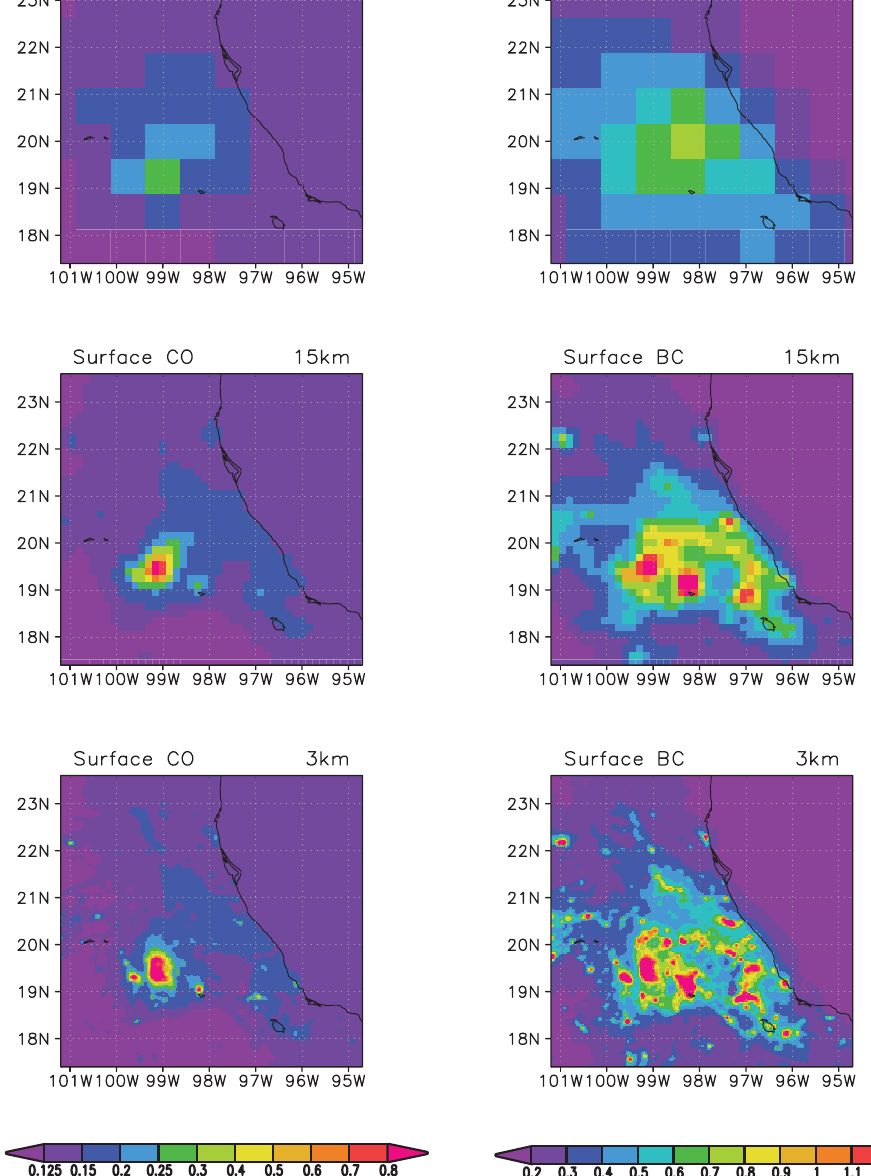
Fig. 5. Same as Fig. 3 but for bottom model level CO concentration (left column, unit: ppm) and BC concentration (right column, unit: µgkg − 1 )